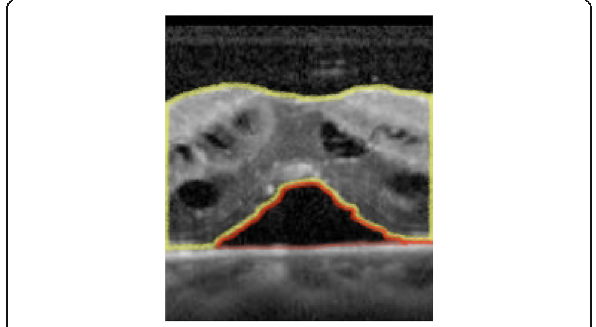
Fig. 1 1-mm Cross-sectional OCT demonstrating